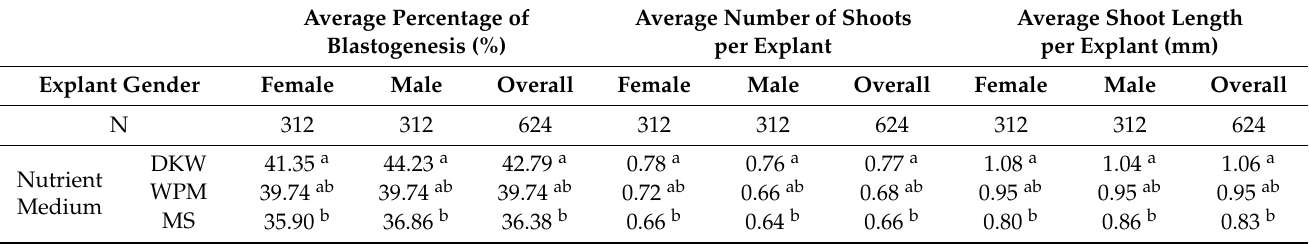
Table 3. Effect of the medium on the average percentage of blastogenesis (%), average number of shoots, and average shoot length of Juniperus drupacea explants in relation to their gender